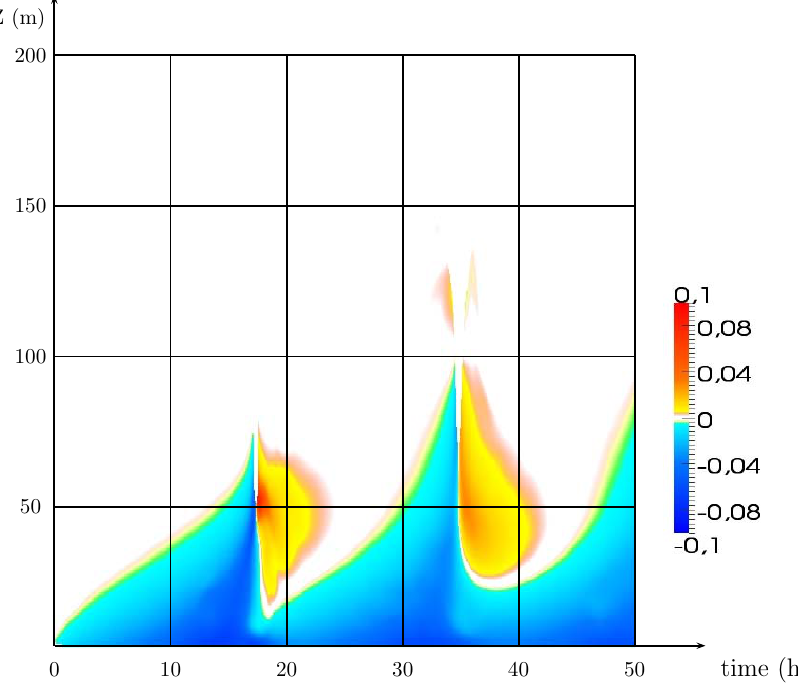
Fig. 12. The quantity shown is given in Eq. (39) and measures the horizontally averaged veering of the velocity vector. The periodic build up of an Ekman spiral is clearly observed in the bottom Ekman layer as is the absence of an inter-facial Ekman